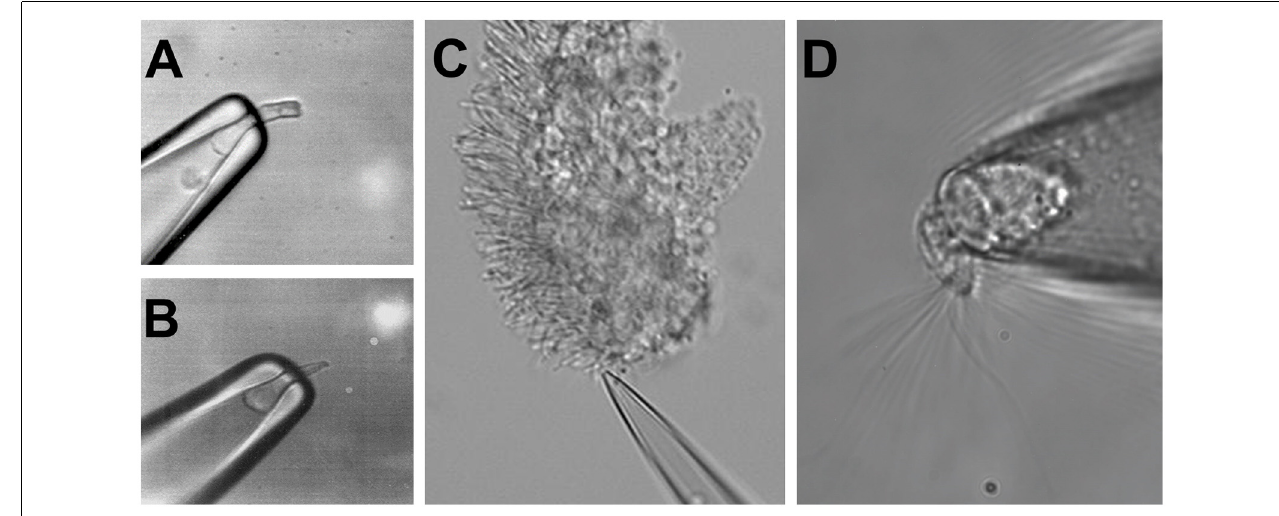
FIGURE 2 | Suction electrode recordings of photoreceptors and OSNs. Suction electrode with a sucked salamander rod (A) and a salamander cone (B) . (C) Suction electrode with a mouse rod from a fragment of the dissected retina. (D) Suction electrode with a single salamander OSN. Figures modified from Reisert and Matthews (2001), Kefalov et al. (2010), and Kefalov (2012) with permission.